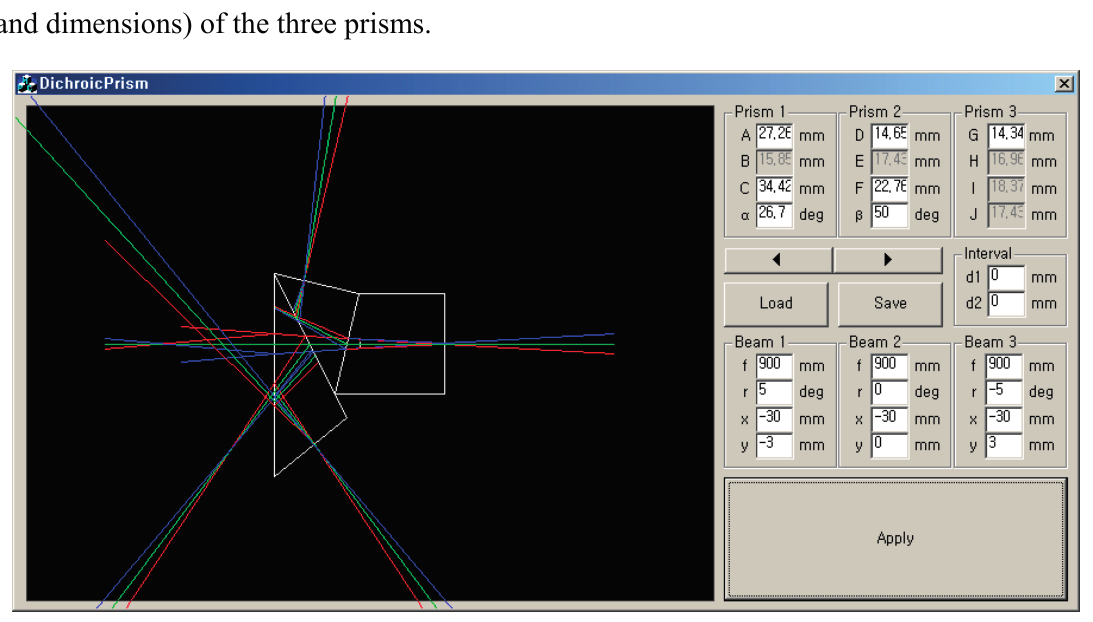
Figure 2. A screen capture of the simulation software. Simulation shows the wavelength-dependent path of incident rays and provides optimal arrangements ( i.e. , angles and dimensions) of the three